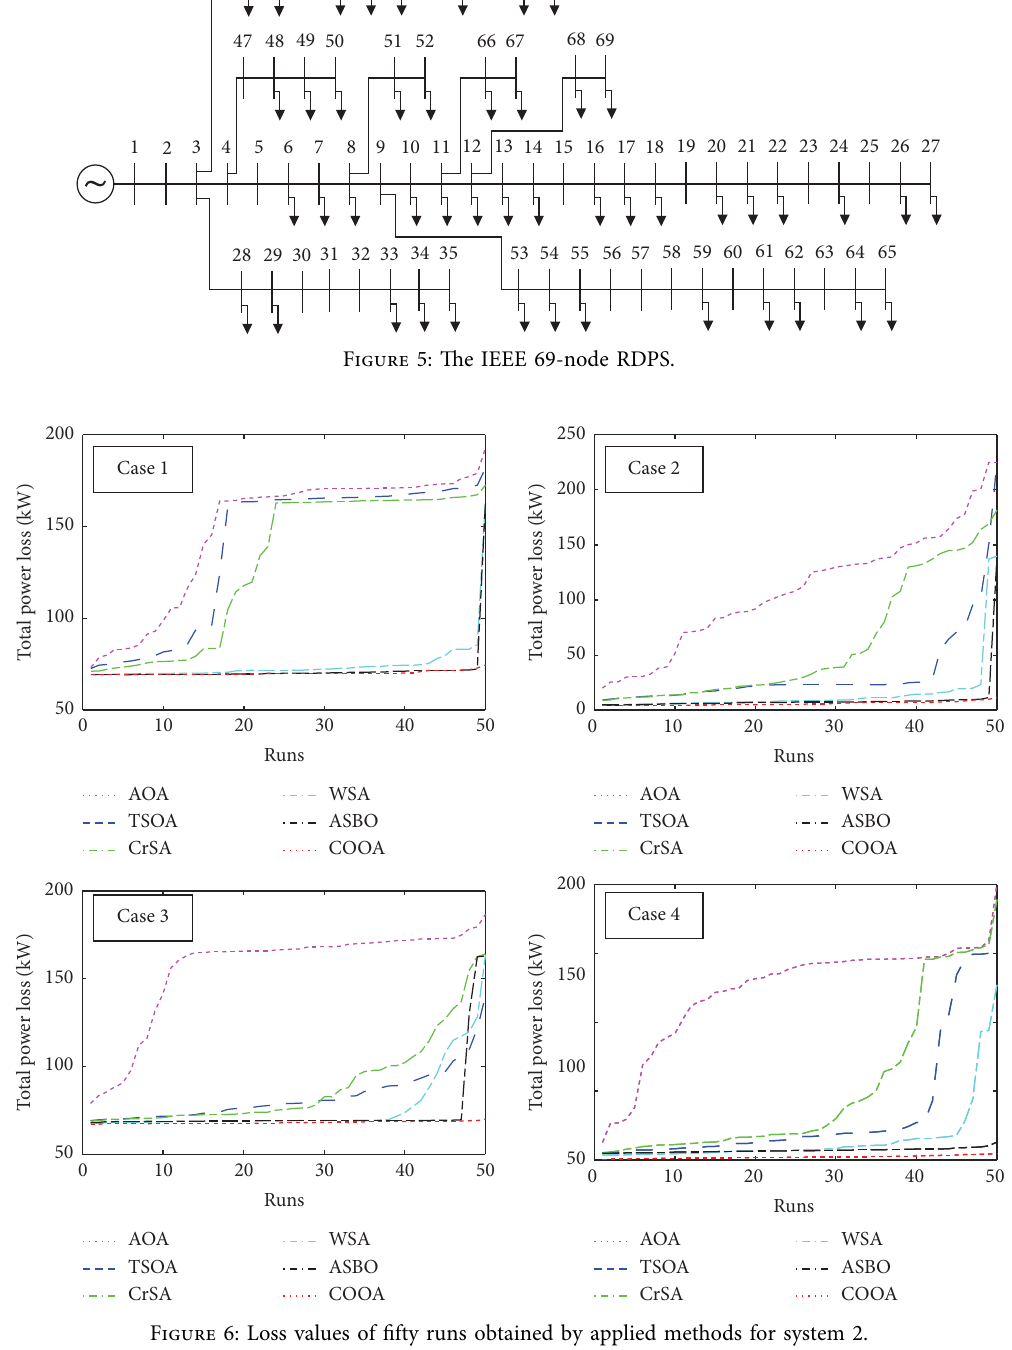
Figure 6: Loss values of ffty runs obtained by applied methods for system 2.